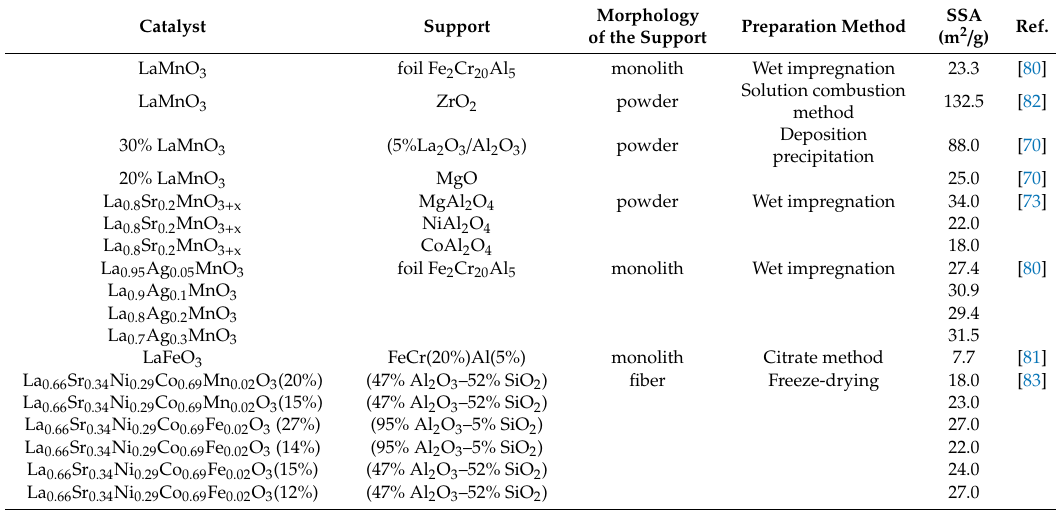
Table 5. The e ff ect of the preparation methods on the SSA of supported perovskites.